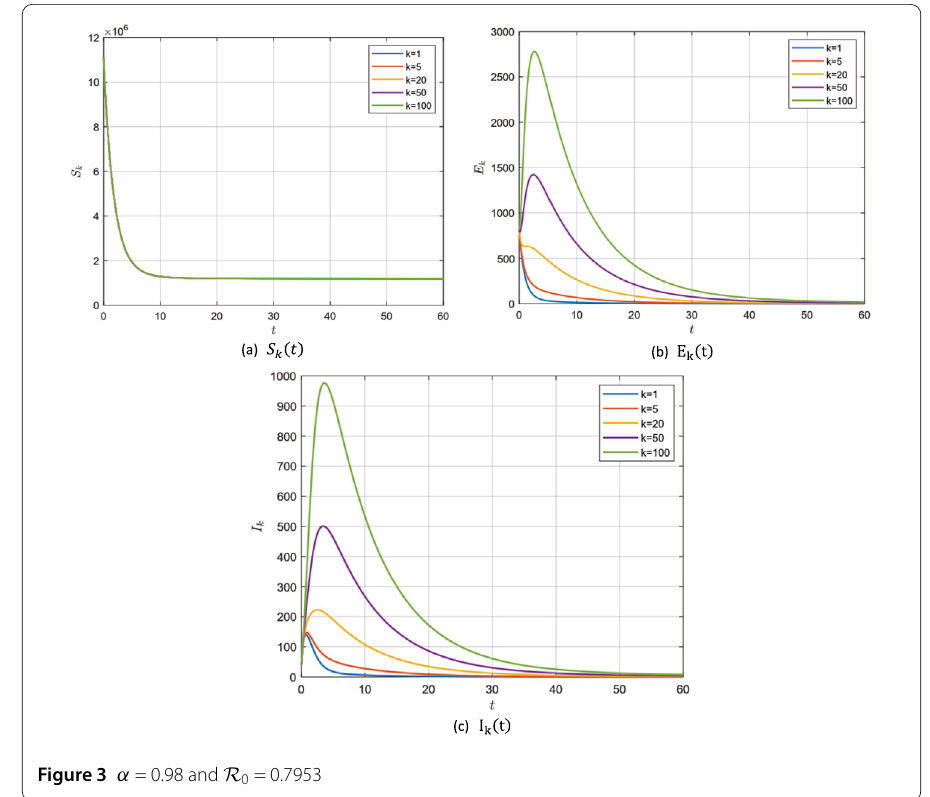
Figure 3 α = 0.98 and R 0 = 0.7953